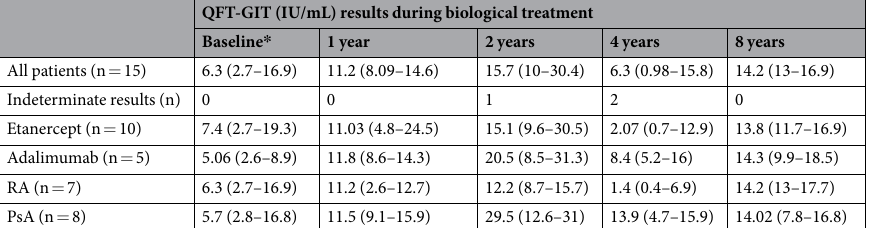
Table 2. Changes occurred in the quantitative mitogen-induced IFN γ responses from QFT-GIT taken at the different time points during treatment with TNF antagonists. * Prior to the onset of biological treatment. The values expressed as IU/ml are median with interquartile range. Note: QFT-GIT = QuantiFERON-TB Gold In- Tube; RA = rheumatoid arthritis; PsA = psoriatic